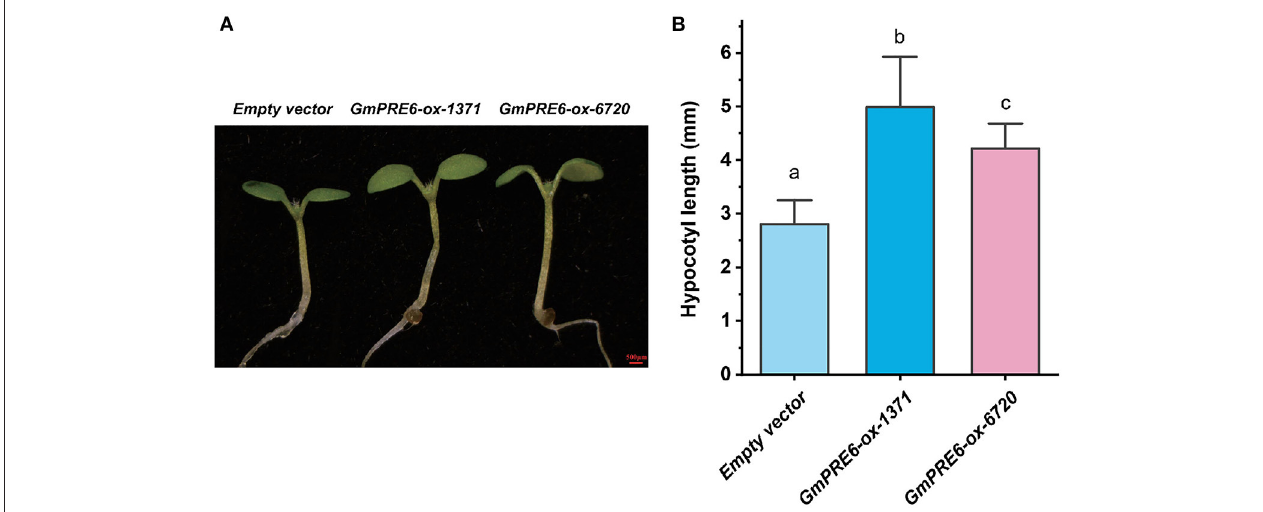
FIGURE 6 | The hypocotyl phenotype of Arabidopsis seedlings overexpressing one GmPRE6 . (A) Overexpression of the GmPRE6 induces a long hypocotyl phenotype in transgenic seedlings. Seedlings were grown for 5 d under light condition. (B) Hypocotyl length measurement. Data are presented as mean ± SD ( n = 13–19). Different letters (a, b) indicate significant difference (two-tailed Student’s t -test).